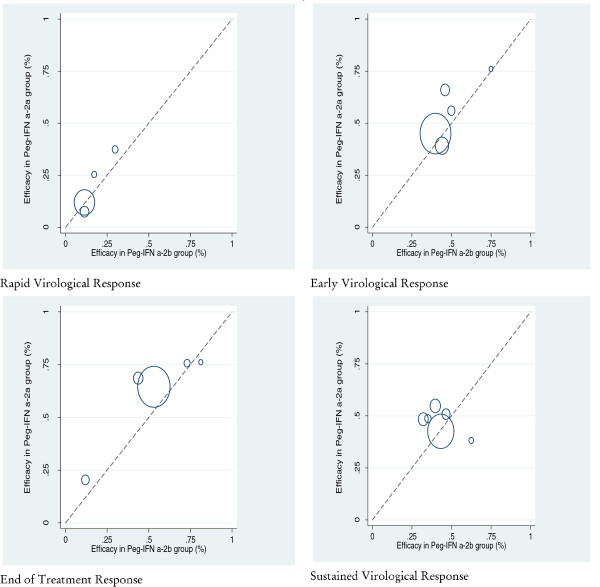
L’Abbé plot for efficacy rate in Peg-IFN α-2a and Peg-IFN α-2b groups on the different outcomes of interest.